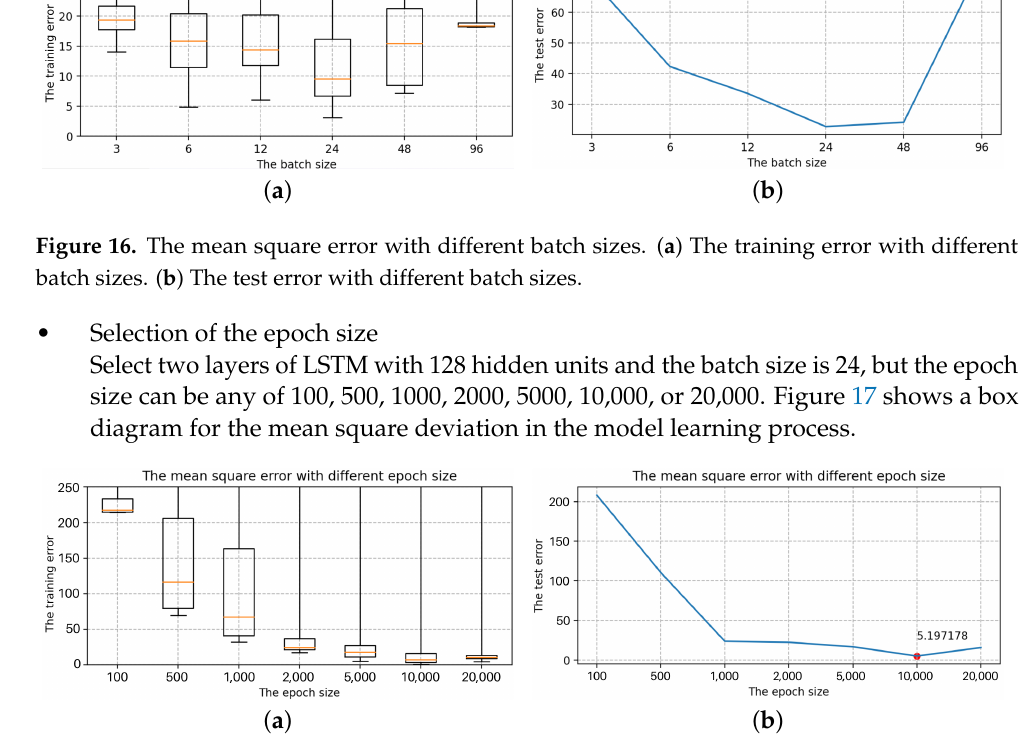
Figure 17. The mean square error with different epoch sizes. ( a ) The training error with different epoch sizes. ( b ) The test error with different epoch